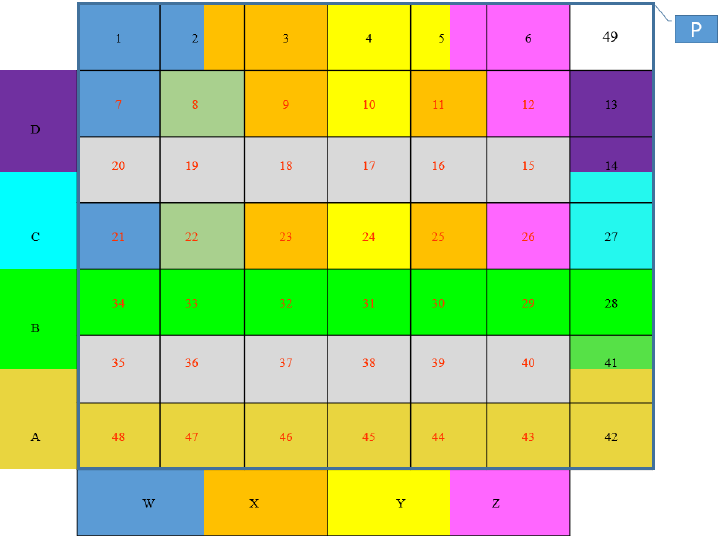
Figure 10. The 4 × 4 sensors 2D array with overlapping arrangement of sensors A, B, C, D, W, X, Y, and Z, plus pressure sensor (P). Each color denotes the corresponding sensors in each tactel.